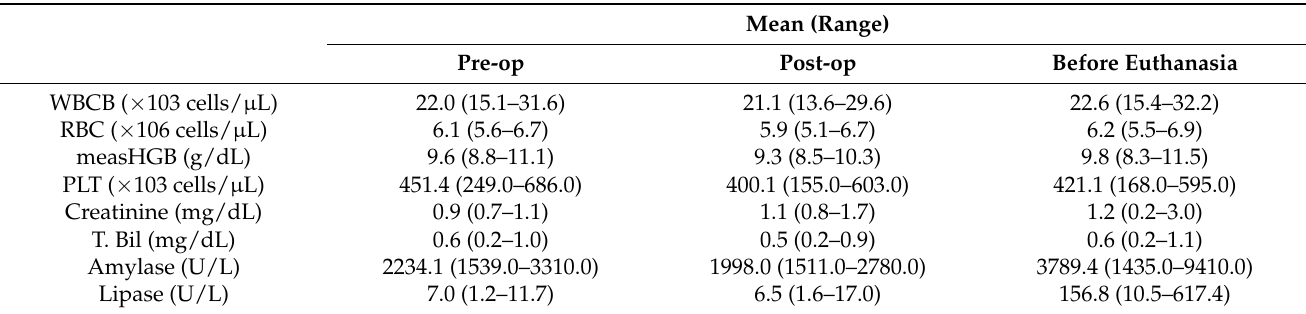
Table 1. Summary of blood tests at various time points (pre-operation, post-operation, and before euthanasia).